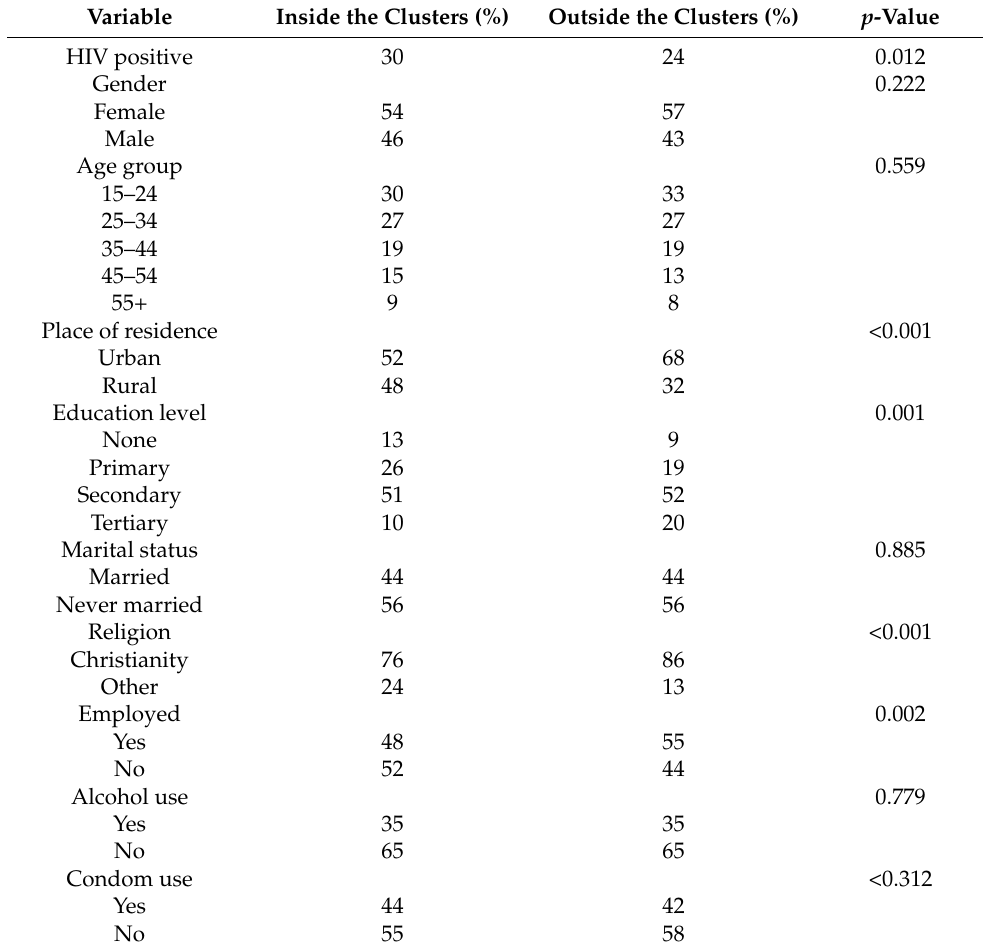
Table 3. Comparison of socio-demographic characteristics between participants within and outside the